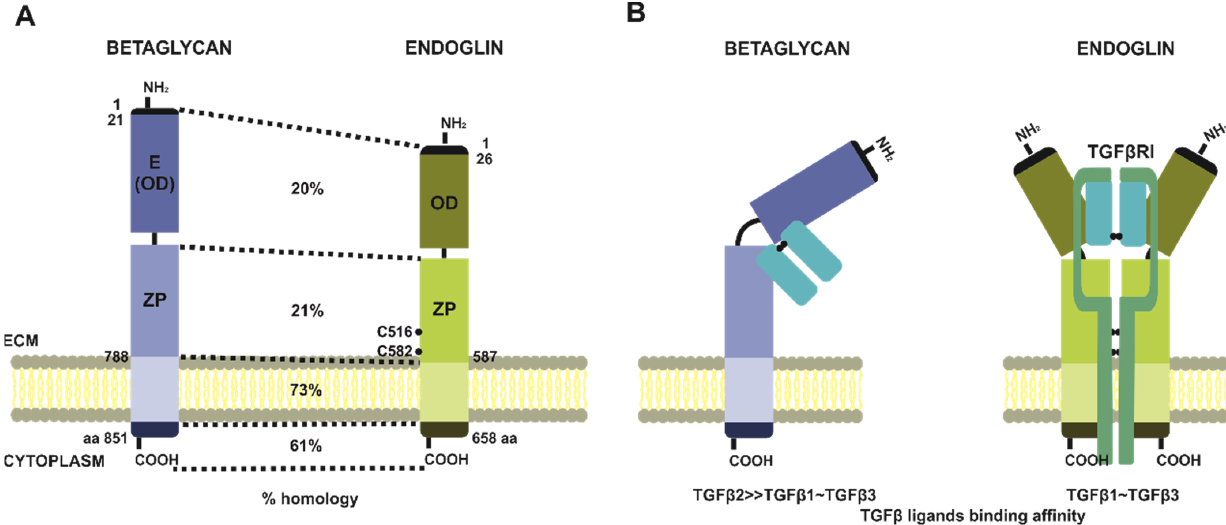
Figure 4. Comparison of TGF β co-receptors i.e., betaglycan and endoglin domain structure homology ( A ) and conforma- tional changes upon TGF β dimers binding ( B ); E: endoglin related domain; OD: orphan domain; ZP: zona pellucida domain; ECM: extracellular matrix.